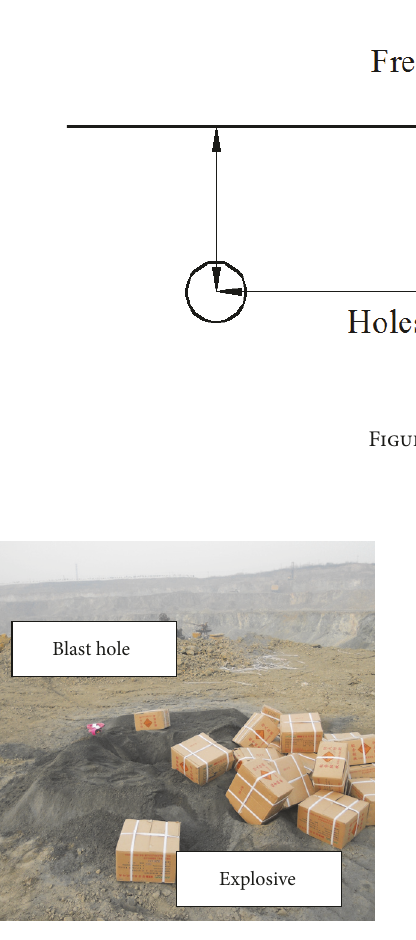
Figure 12: Picture of the field experiment.